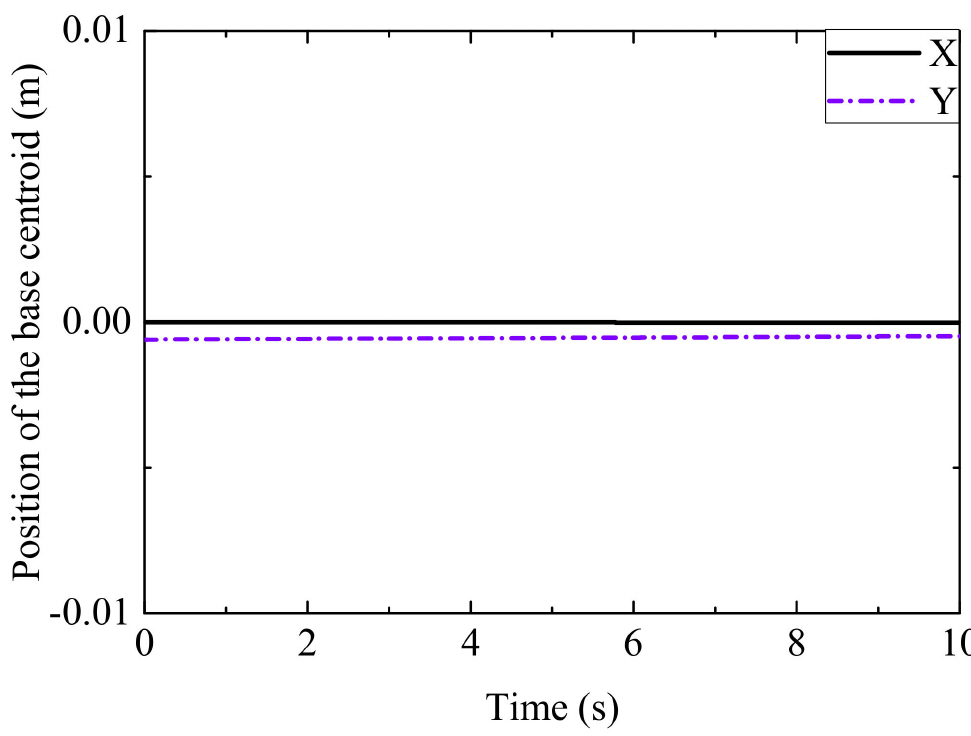
Figure 20. Position of the base centroid in the trajectory tracking stage.